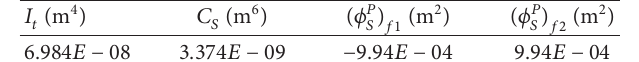
Table 2: Maximum deflection 𝑤 𝑝 (cm) at point A of the first cycle of motion of the stiffened plate for various values of 𝐾 of Example 1. 𝐾 Linear analysis Nonlinear analysis